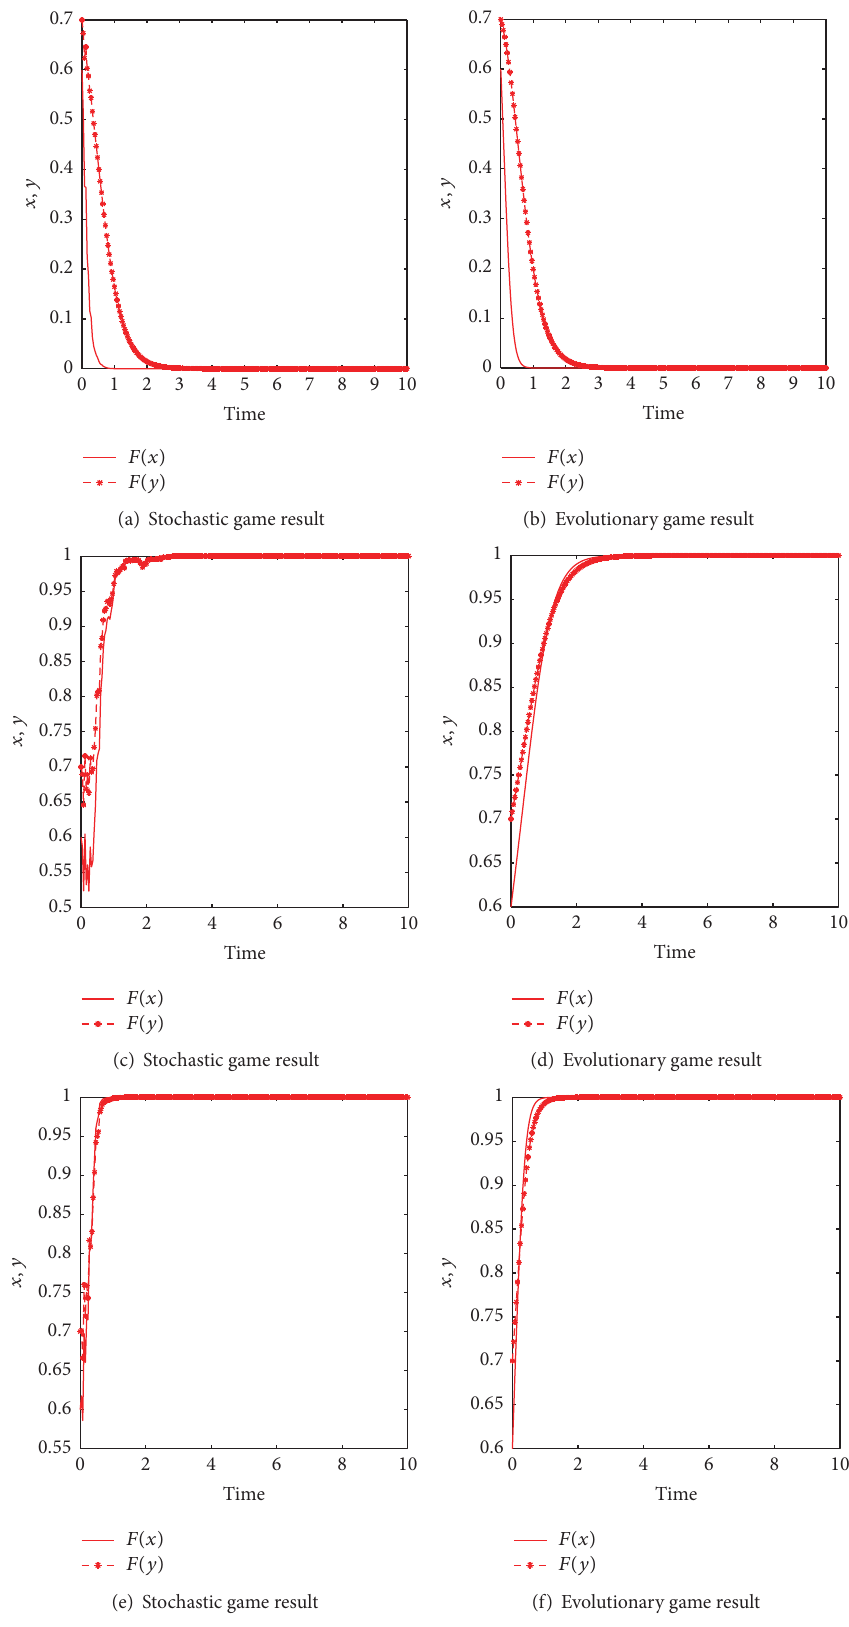
Figure 8: Result comparison of stochastic game result and game under definite